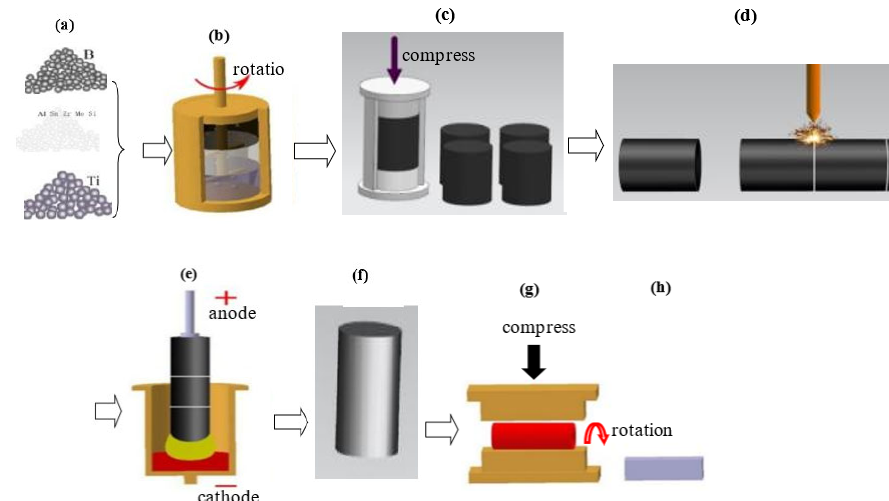
Figure 1. Schematic of the preparation and thermal deformation of the composite reinforced with short in situ TiB fibers. ( a ) raw powders; ( b ) mixed mechanically; ( c ) pressed into rod; ( d ) rods were welded as an electrode; ( e ) electrode were remelted in a vacuum arc remelting furnace; ( f ) composite casting; ( g ) composite performed thermal-processing; ( h ) composite after thermal-processing.